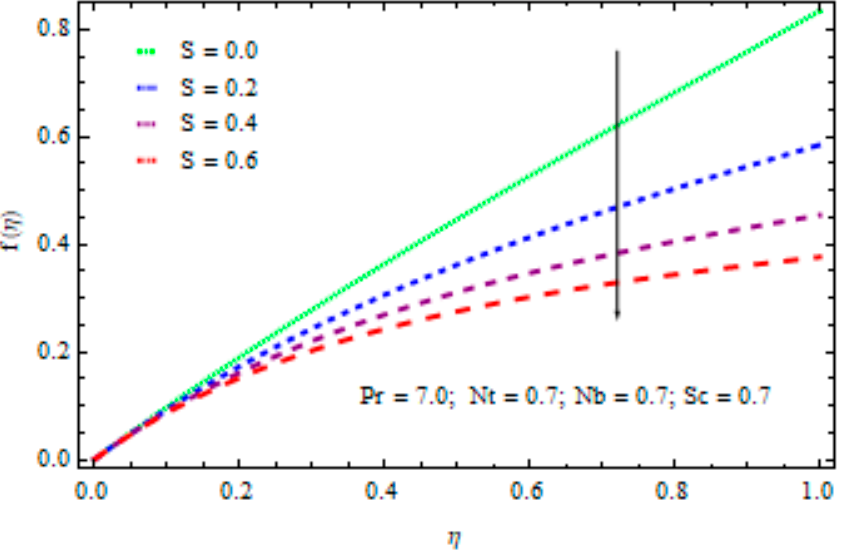
Figure 10. The impact of the unsteady parameter S on the radial velocity.